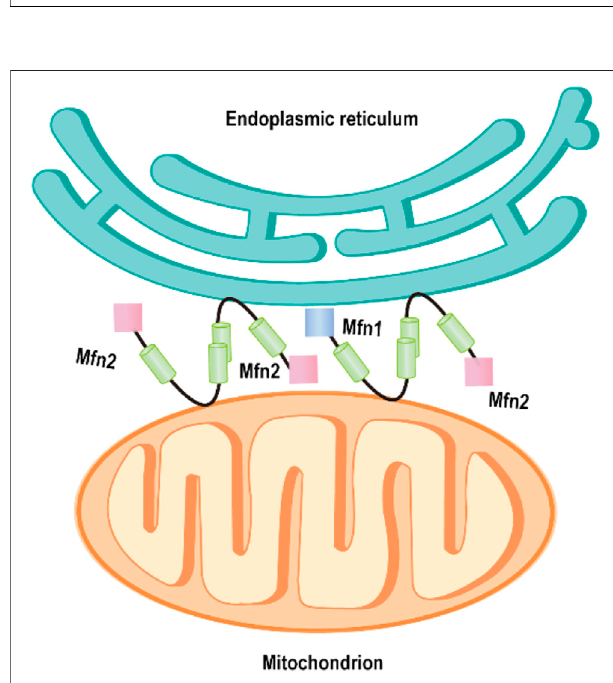
FIGURE 3 | Mfn2 tethers endoplasmic reticulum to mitochondria. Mfn2 on the ER membrane interacts with Mfn2 or Mfn1 on the outer mitochondrial membrane, mediating the ER – mitochondria